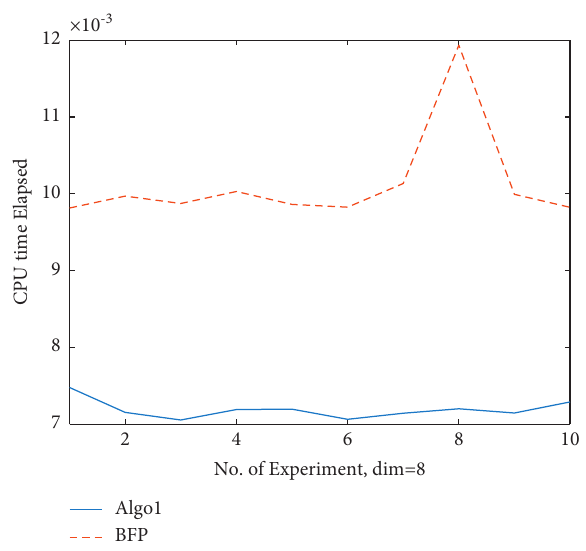
Figure 11: CPU time vs no. of iteration for dimension